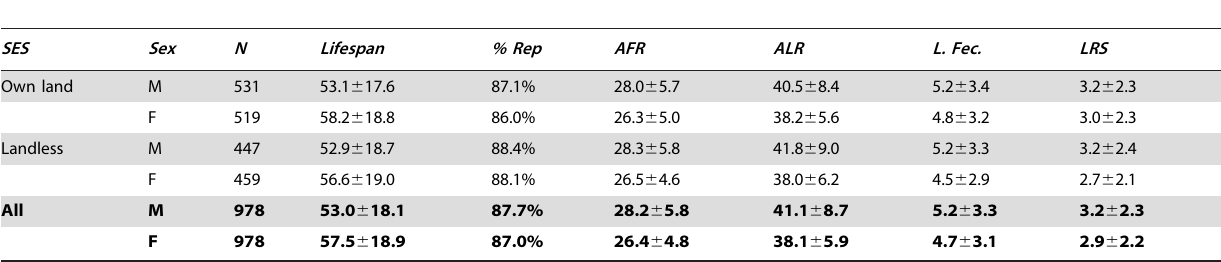
Table 1. Descriptive statistics of reproductive parameters of F1 individuals who survived to age 15 and were successfully followed until the end of potential reproductive life, split by sex and parental socio-economic status (mean 6 s.d.).